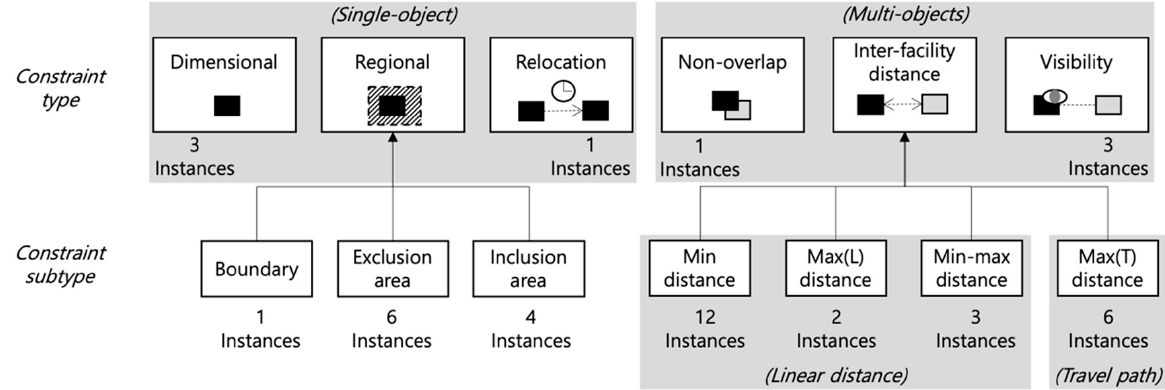
Figure 3. CSLP constraints types and subtypes.